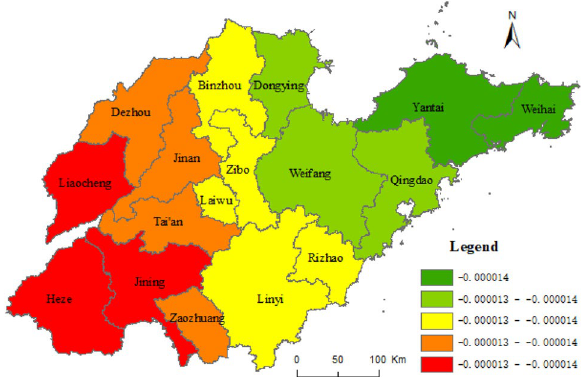
Figure 10. Coefficient of X 1 . This figure was created with ArcGIS 10.5 (URL: http:// www. esri.